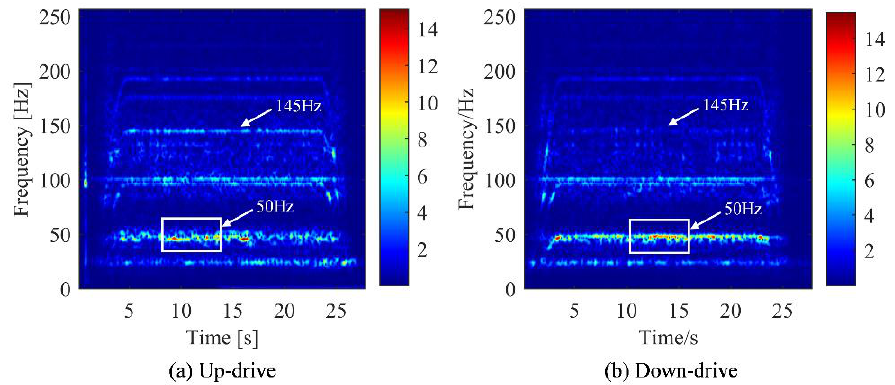
Figure 6. Time frequency diagram of main machine vibration in different operating directions of elevator (2.4 m/s). ( a ) Motor with up-drive condition. ( b ) Motor with down-drive condition.